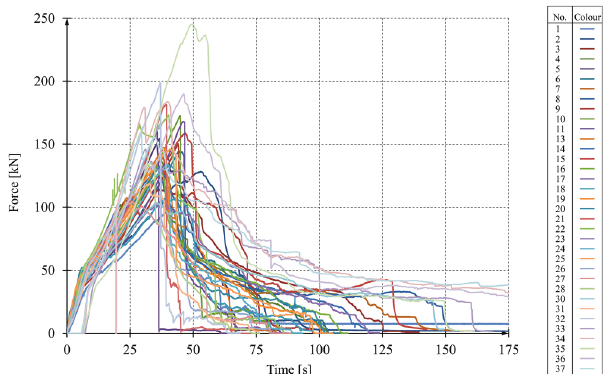
Fig. 8. Changes of load transferred by pile-brick specimen